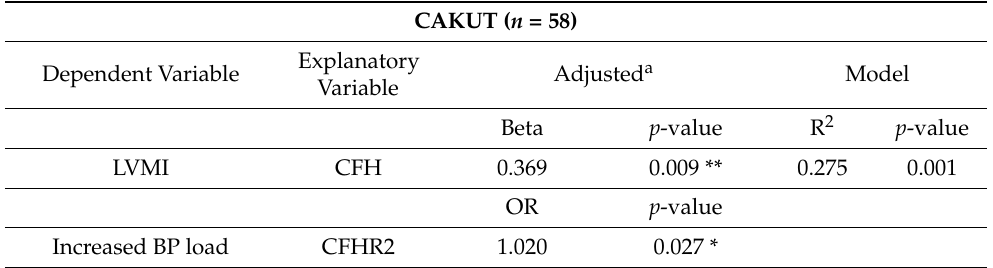
Table 5. Regression model of cardiovascular risks and CFH-related proteins in the CAKUT group.